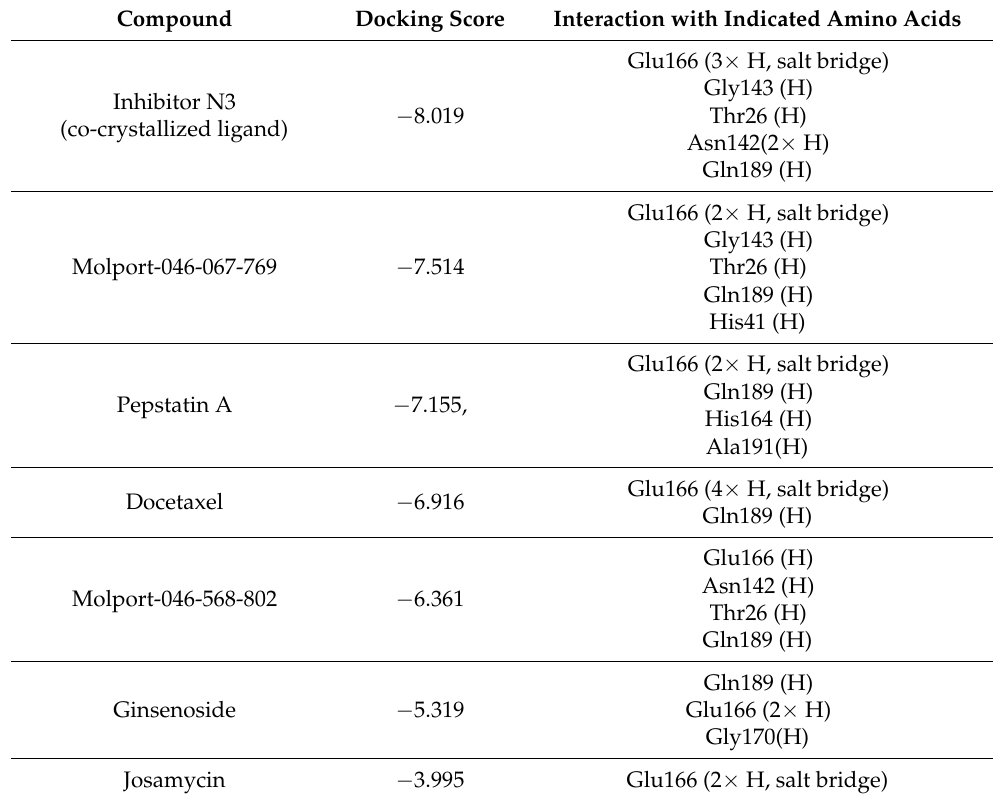
Table 6. Potential anti-SARS-CoV-2 compounds selected by Molecular Topology and docking score for Mpro